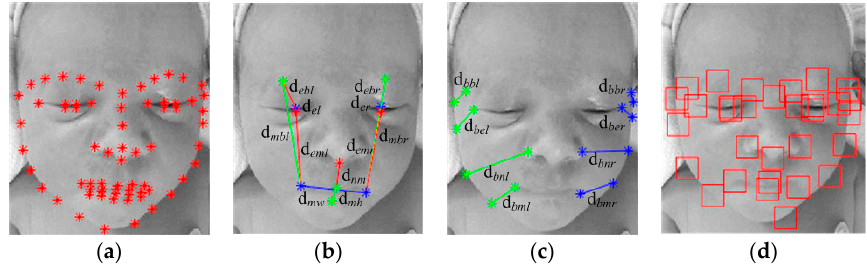
Figure 1. Frame-level parameters of infant pain facial expression. ( a ) Facial landmarks; ( b ) facial configuration parameters; ( c ) head pose parameters; ( d ) landmark patches.